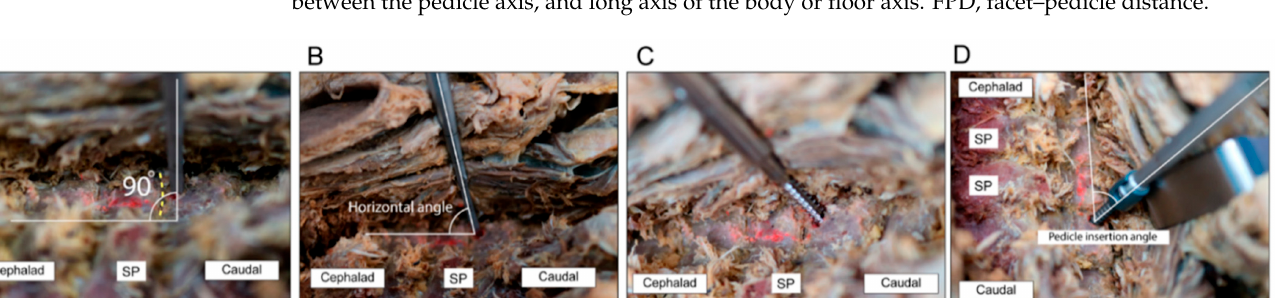
Figure 2. ( A ) Cervical spine of a vertebral model showing the starting point and corresponding computed tomography image (sagittal view) ( B ) The starting point was located between the center, and medial third of the lateral mass, at a specific distance from the tip of the inferior articular process of the cephalad vertebra. The facet-pedicle distance was estimated using the diameter of the burr tip (3 mm) used to drill the initial hole in the lateral mass. The horizontal angle represents the angle between the pedicle axis, and long axis of the body or floor axis. FPD, facet–pedicle distance.